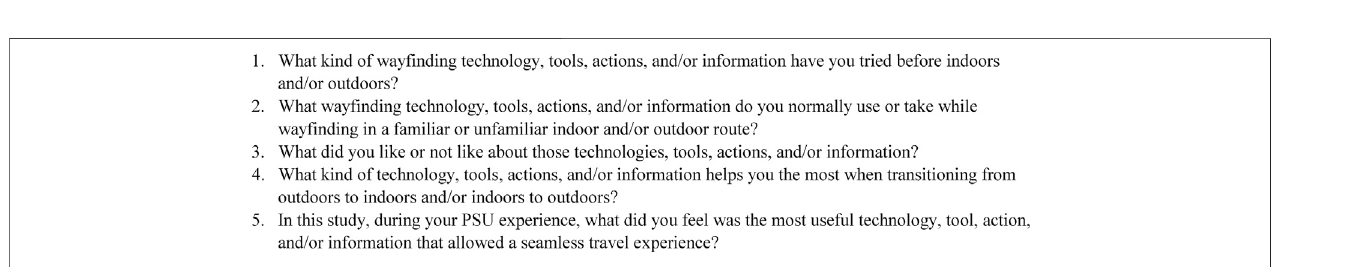
Frontiers in Education |